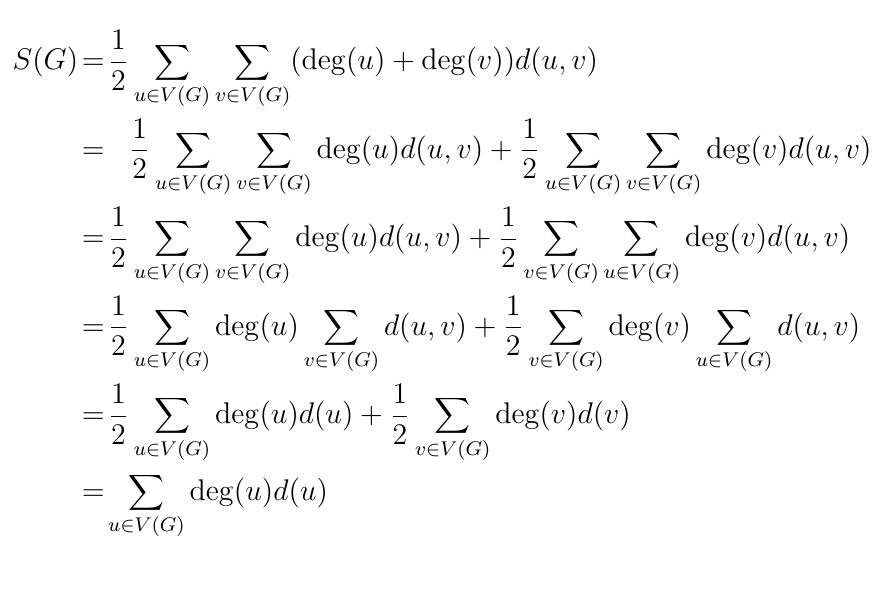
Figure 3. Distances from x